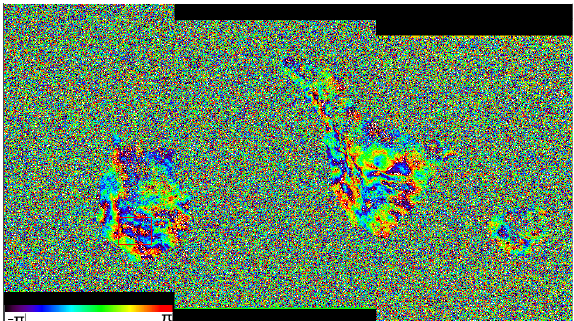
Figure 2. Interferogram with atmospheric artefacts generated from Sentinel master and